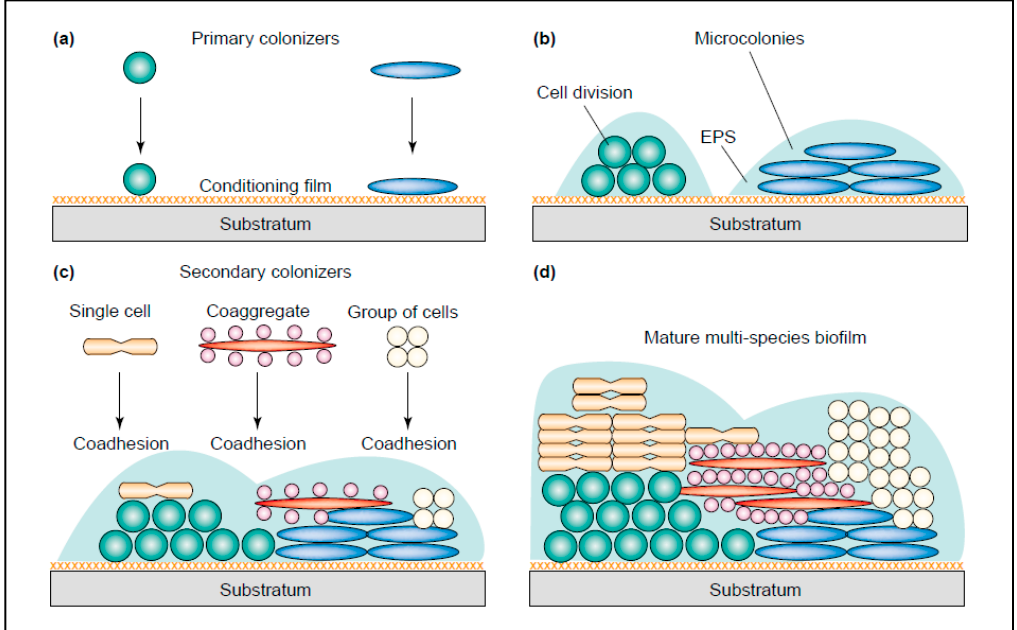
Figure 1. The development of a multi-species biofilm (plaque). ( a ) Early colonizers bind to the conditioning film (pellicle) ( b ) The early colonizers start to grow and divide and form microcolonies. The production of EPS starts ( c ) Co-adhesion of single cells, groups of cells and co-aggregates occur ( d ) Maturation of the complete plaque (Image taken from: [19] with permission).